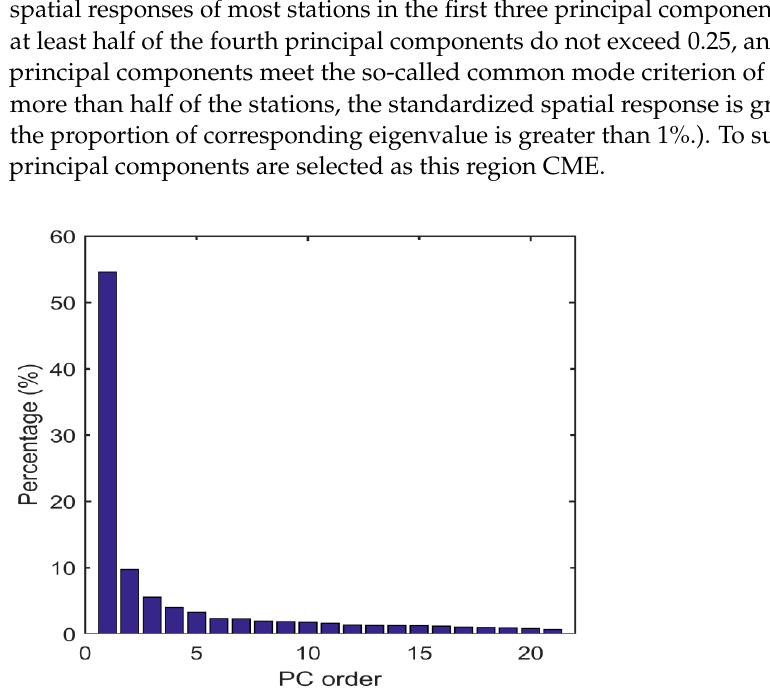
Figure 3. Contribution rate corresponding to the vertical component of the first 21 eigenvalues of PCA filtering. Table 1. The PCA method for extracting the first 4 normalized spatial eigenvectors.